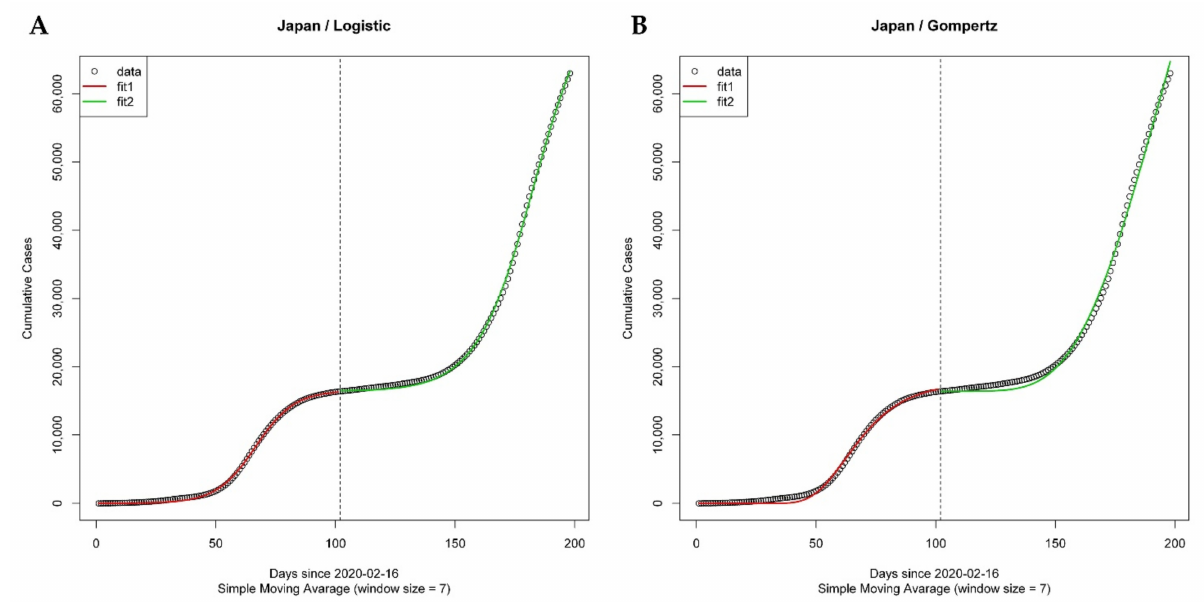
Figure 1. Cumulative confirmed cases divided into two segments using the segmentation algorithm. Japan is the typical country with two waves (red: first segment and green: second segment). ( A ) Epidemic segmented growth curve of COVID-19 fitted by the logistic model. Estimated parameters were ( α 1 , β 1 , γ 1 , α 2 , β 2 , γ 2 ) = (16549.7588, 7.8244, 0.1231, 58877.8030, 6.7353, and 0.0859, respectively). ( B ) Epidemic segmented growth curve of COVID-19 fitted by the Gompertz model. Estimated parameters were ( α 1 , β 1 , γ 1 , α 2 , β 2 , γ 2 ) = (17,531.5024, 89.4251, 0.0760, 98,622.3568, 15.6933, and 0.0325,